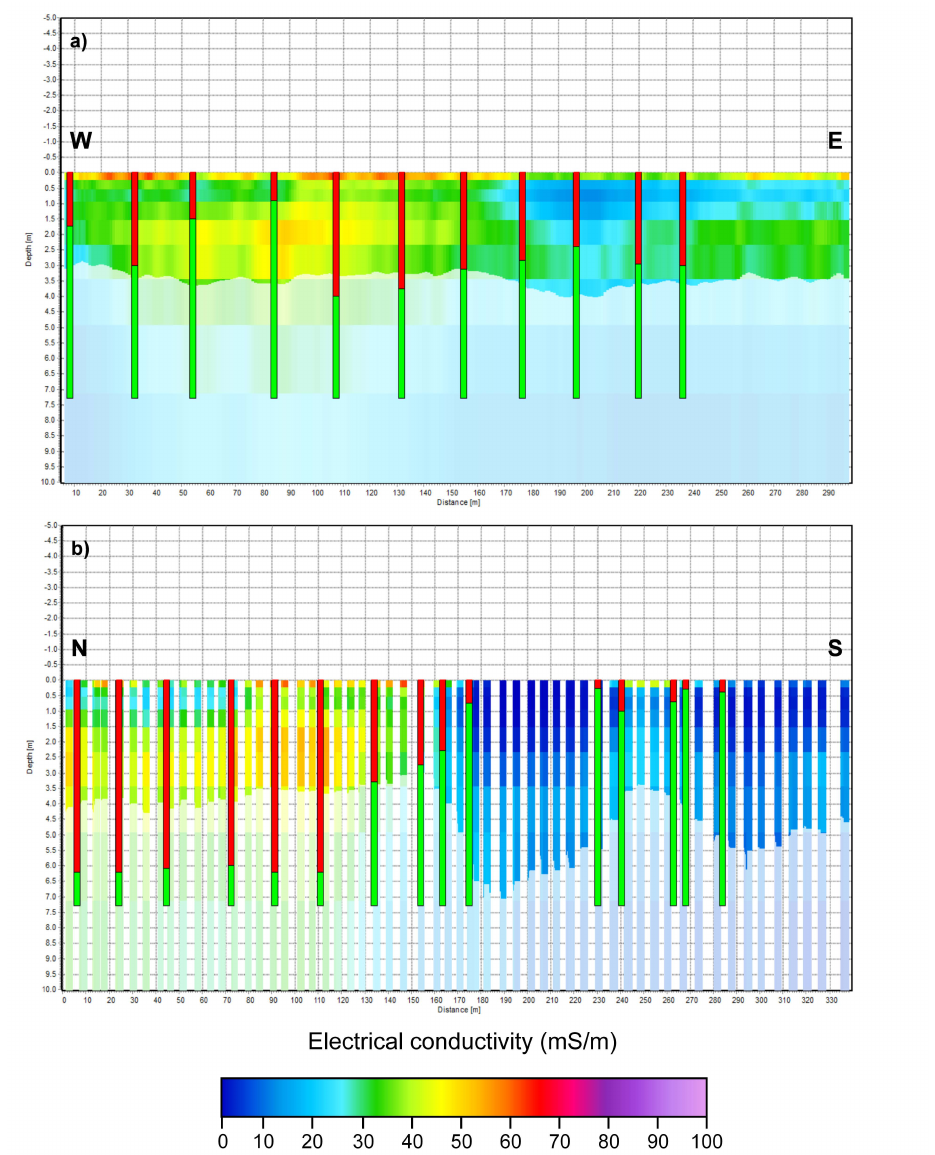
Figure 11. Cross-sections S1 ( a ) and S2 ( b ) showing the calculated σ smooth estimates (for each soil observation site, peat layers are represented in red and underlying layers in